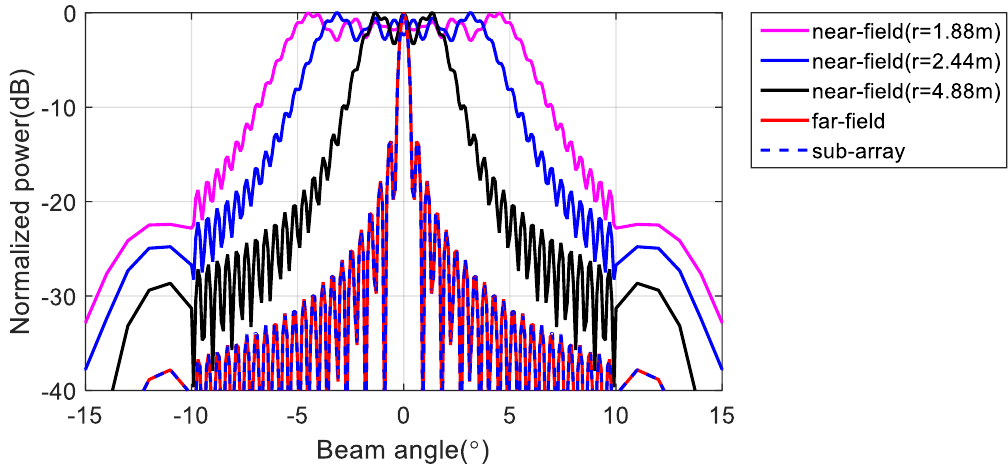
Figure 7. Beam pattern for the near field obtained by the proposed method and beam pattern for the far and near fields.